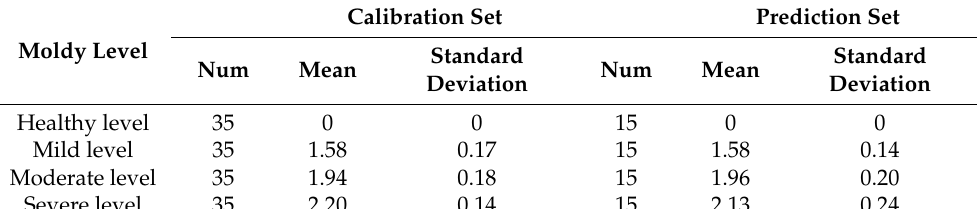
Table 2. Division of maize with different moldy levels in the calibration and prediction sets.